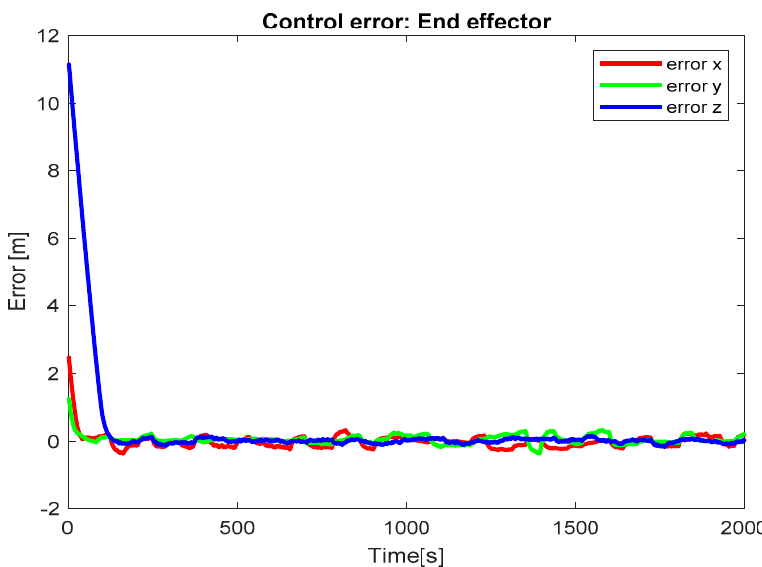
Figure 11. Control errors: Inverse Dynamics controller.